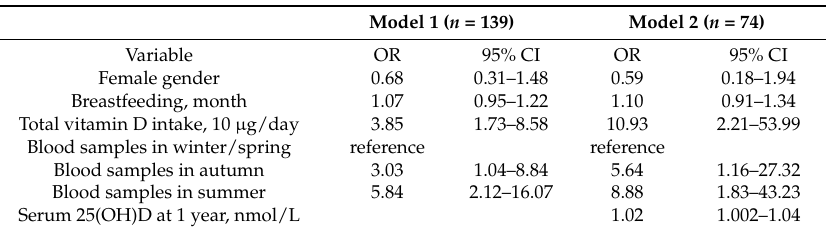
Table 2. Multivariate logistic regression analysis of factors associated with vitamin D sufficiency